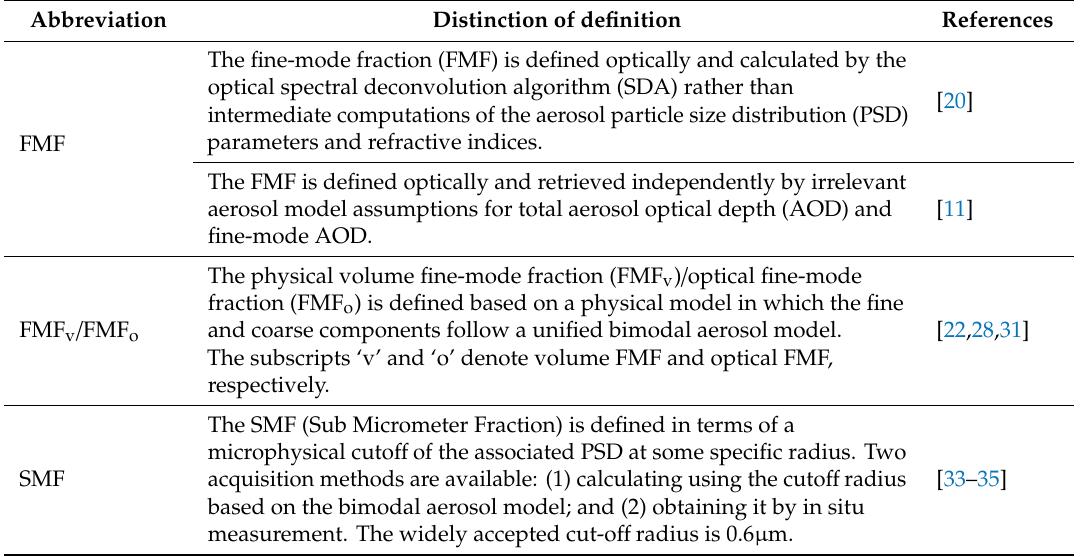
Table 1. Definitions for the proportions of fine aerosols to total aerosols in di ff erent